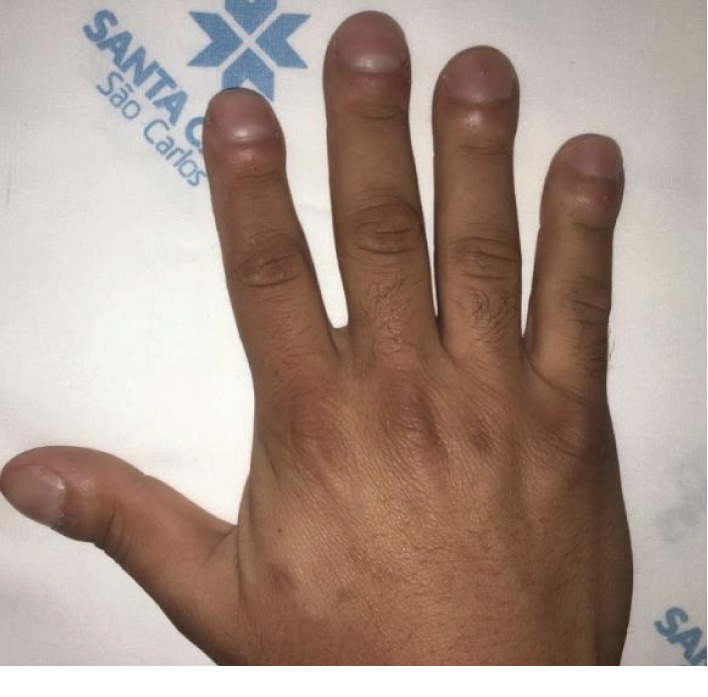
Digital clubbing.